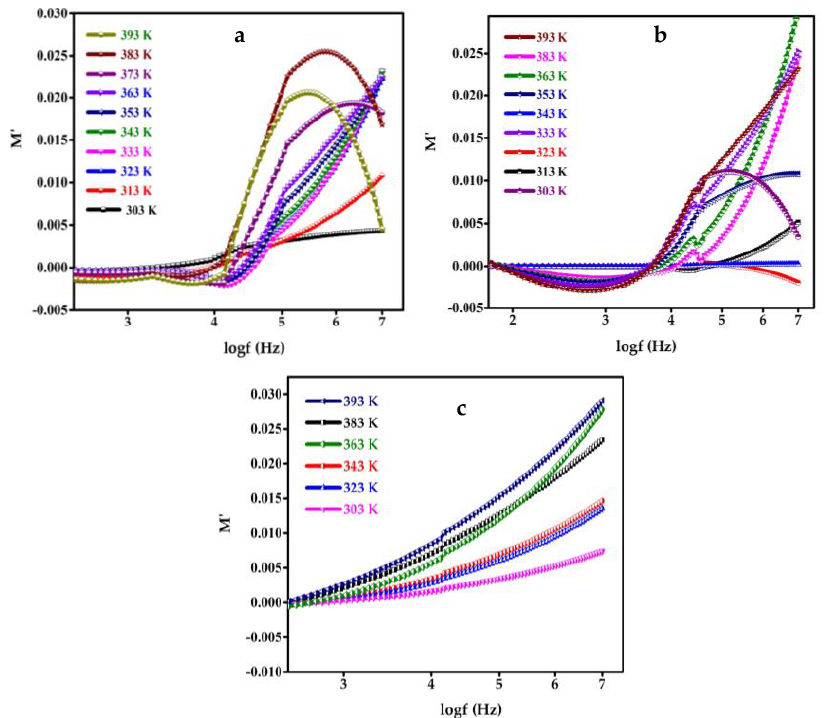
Figure 12. Electric modulus (M′) variation as a function of frequency at different temperatures for ( a ) SnO 2 QDs, ( b ) GO, and ( c ) SGP2 composite film. B ecause of the suppression of electrode polarization at low frequencies, M′ ap- proaches zero; however, M′ increases with frequency, indicating that the restoring force determines the mobility of charge carriers when an electric field is present. Due to the charge carrier ’ s short-range mobility and the conduction electrons ’ storage mobility, M′′ reaches a maximum value of 1.46 × 10 − 2 as illustrated in Figure 13c.